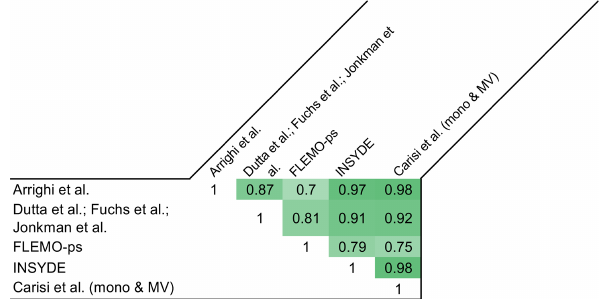
Figure 4. Pearson’s correlation coefficient for individual exposure estimates supplied by the models with reference to all the buildings in the flooded area (the darker the colour, the stronger the correla-